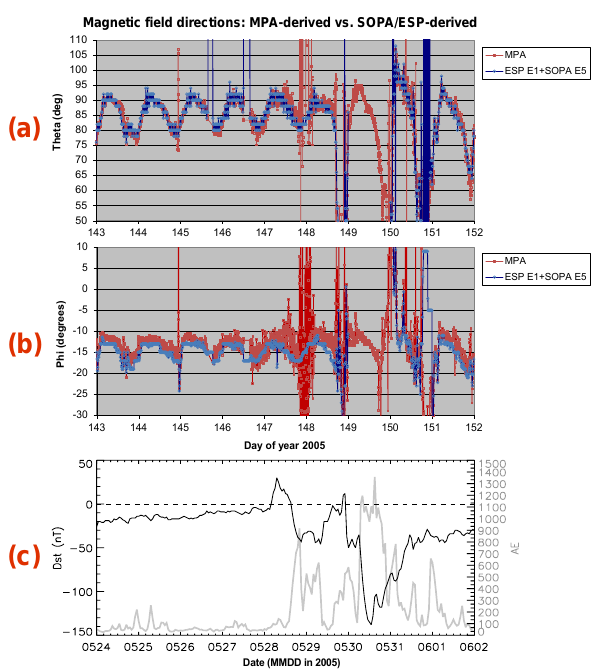
Figure A1. Magnetic field directions derived from MPA aboard LANL-01A compared to those from SOPA and ESP during a 9-day period. (a) The time series of magnetic field directions’ polar angle theta ( θ ) derived from MPA (red) are compared to those from SOPA and ESP (blue). LANL-01A crosses midnight at ∼ 23:00UT each day in 2005. (b) Time series of field directions’ azimuthal angle Phi ( φ ). (c) Dst (black) and Auroral Electrojet (AE) (gray) indices for the period. A double-dip storm occurred during the period with the minimum Dst ∼− 135nT reached on 30 May (DOY